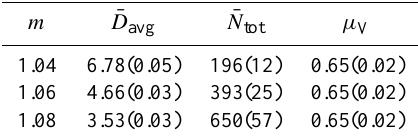
Table 4. Median and central 68th percentile range of cell popu- lation parameters estimated from model outputs for three different nominal values of m (units as in Table 1). ¯ D avg and ¯ N tot are the 24-h averages of D avg and N tot , respectively. µ V is the population biomass-specific growth rate defined in Eq. 12.